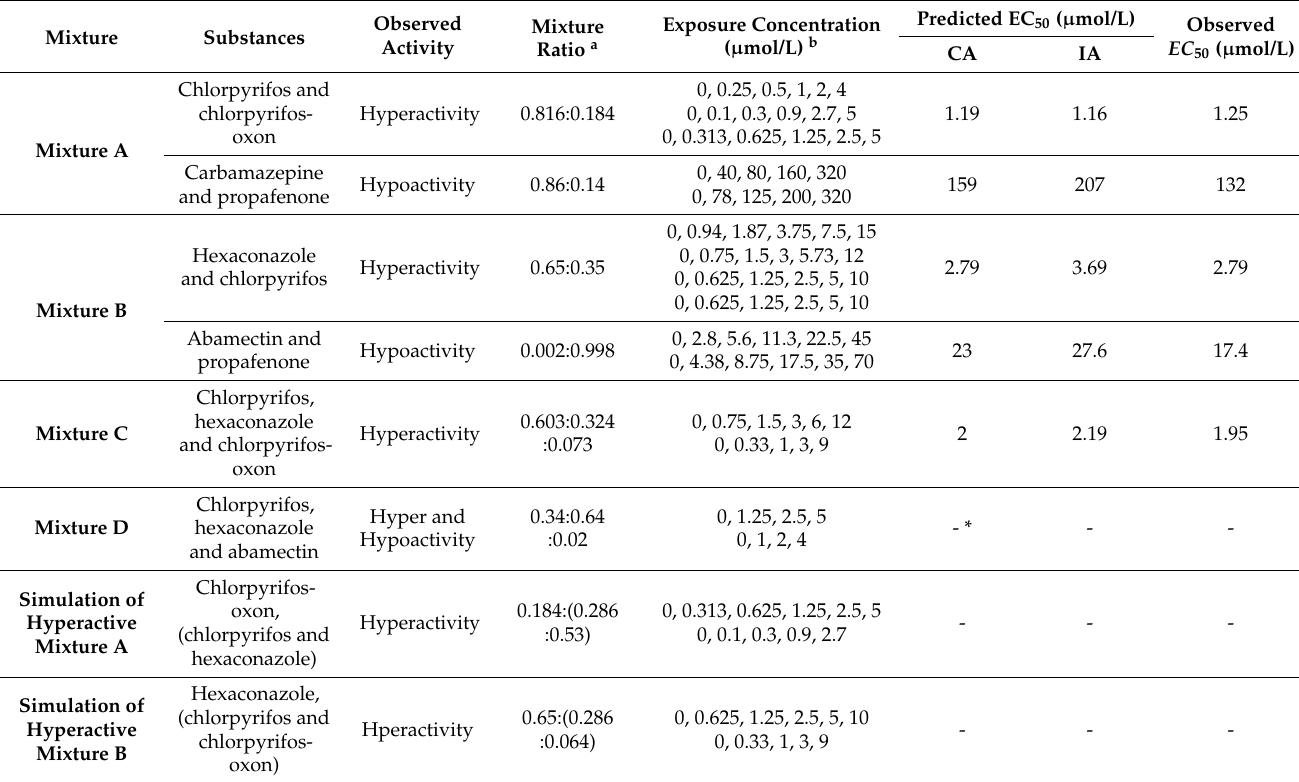
* no mixture and toxicity predictions; a Mixture ratios are calculated as molar fraction of the total concentration. The ratio in the mixture is defined by the ratio of EC 50 s. b The given exposure concentrations refer to the exposure range of independent experiments. In subsequent experiments, often different ranges were used to promote a better description of concentration–response curves. All concentration ranges were combined for concentration–response